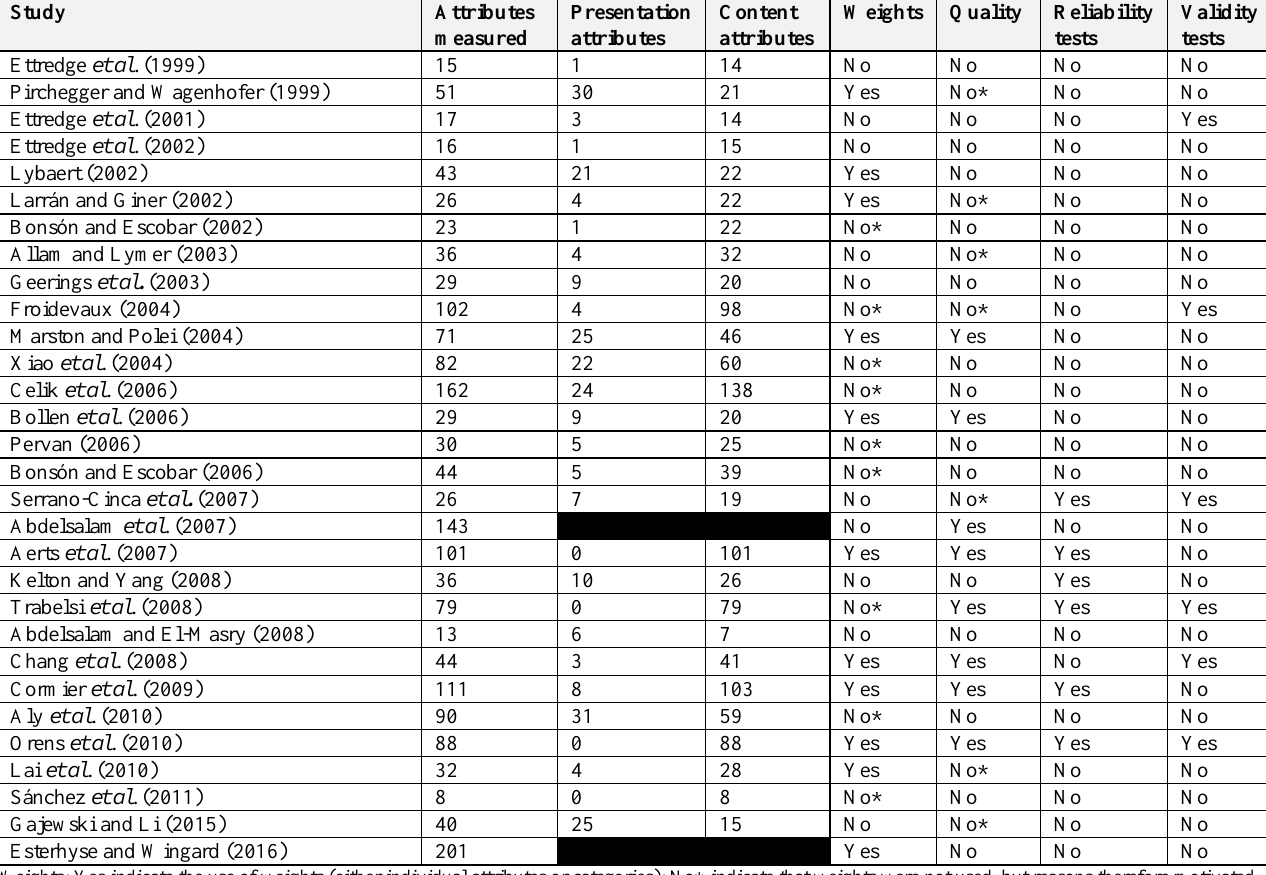
Table 1: Direct disclosure proxy studies (corporate websites as disclosure vehicle) Study